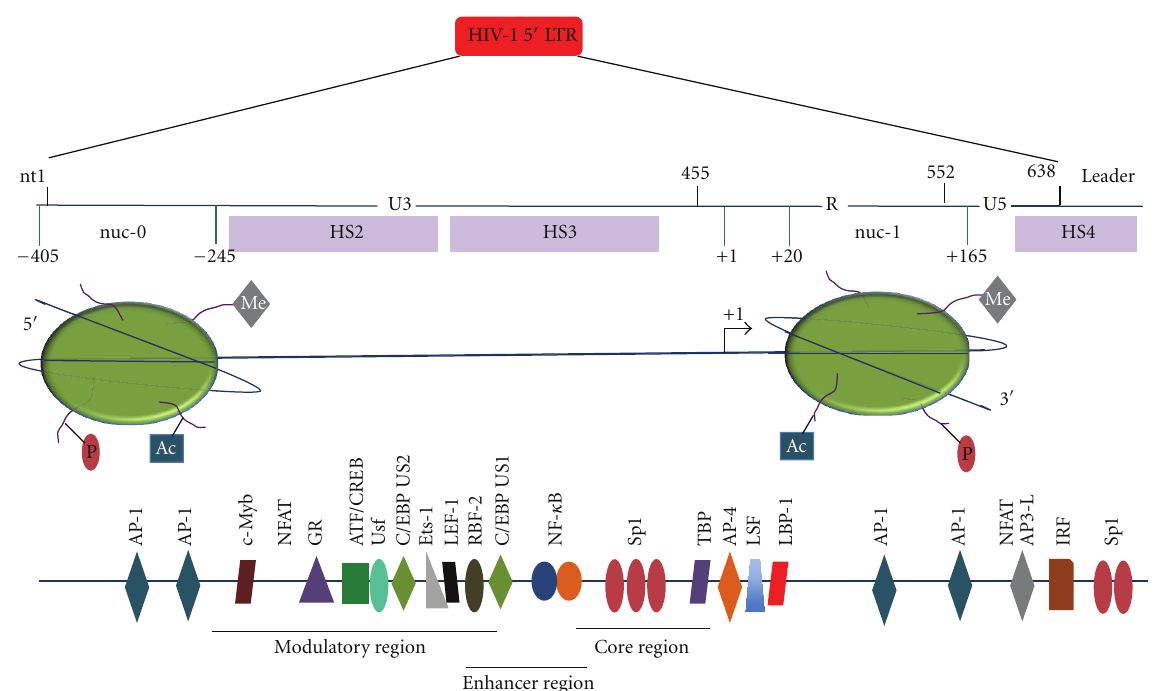
Figure 2: Molecular architecture of the HIV-1 long-terminal repeat. The viral promoter, the long-terminal repeat (LTR), can be divided into the U3, R, and U5 regions. Upon integration, the LTR presents stretches of DNase I hypersensitivity sites (shown as HS2, HS3, and HS4) as a result of the well-defined, conversed positioning of the two nucleosomes; nuc-0 and nuc-1. This architecture results in exposure of stretches of DNA extremely rich in transcription factor-binding sites that include di ff erent regulatory proteins in the process of HIV-1 transcription. These factors respond to various extracellular and intracellular stimuli, resulting in upregulation/downregulation of specific downstream transcription factors that act via binding to their respective binding sites in the LTR. Also, positioning of nuc-1 is crucial because it is present immediately downstream of the start site (+1); this nucleosome needs to be remodeled for active processive transcription to ensue from the LTR. Moreover, modifications like acetylation, phosphorylation, and methylation of histone tails regulate LTR-directed transcription. The HIV-1 Tat protein regulates the chromatin environment via interactions with several components including methyltransferases, acetyltransferases, and a number of transcription factors in addition to binding to the TAR element in nascent HIV-1